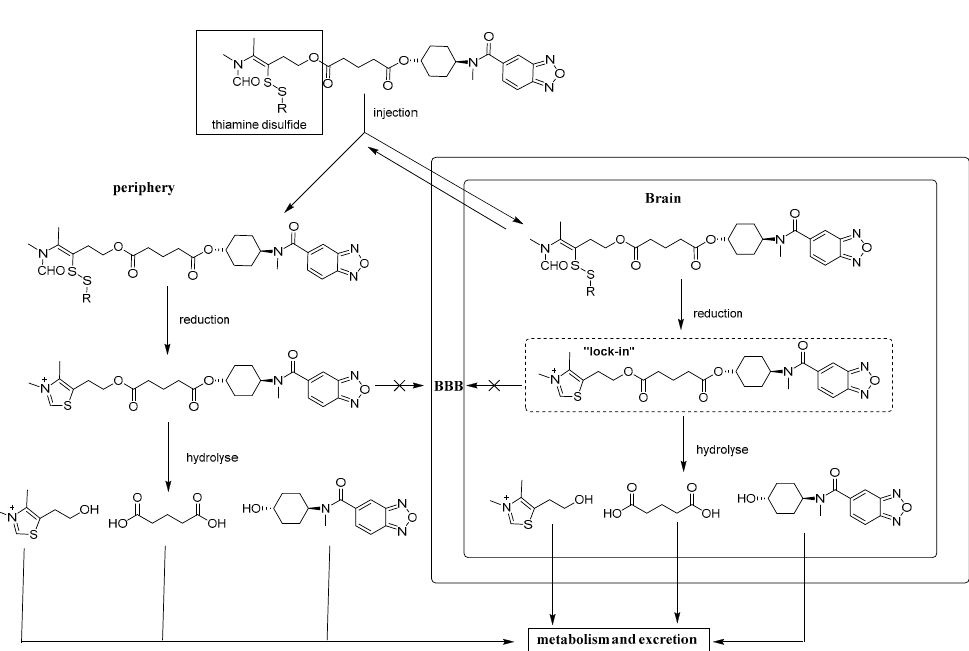
Figure 2. Sequential metabolism and brain “lock-in” pathways of brain-targeted thiamine disulfide prodrugs of LCX001.